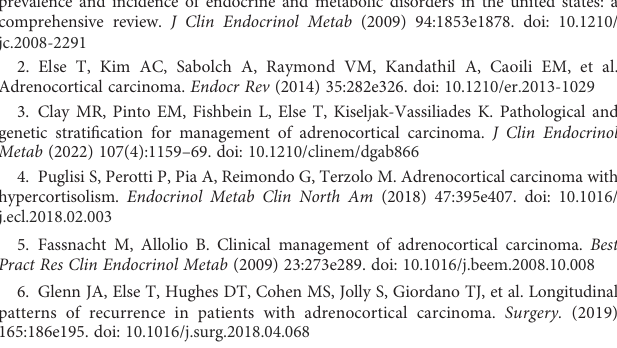
SUPPLEMENTARY FIGURE 1 Correlation between the expression of BET family and the pathological stage of ACC (GEPIA). (A) BRD2 ; (B) BRD3 ; (C) BRD4